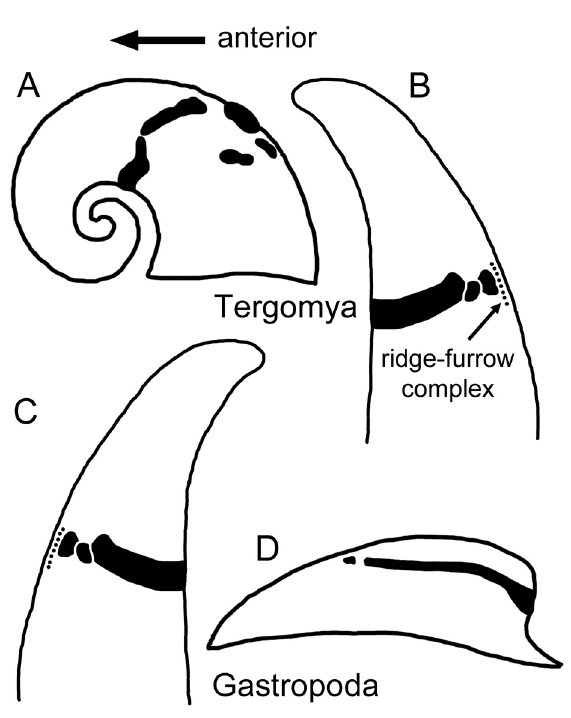
Fig. 4. Muscle scar patterns in Ordovician univalve molluscs. Cyrtolites ( A ) and Pollicina ( B ) intepreted as Tergomya. Pollicina ( C ) and Archinacella ( D ) interpreted as